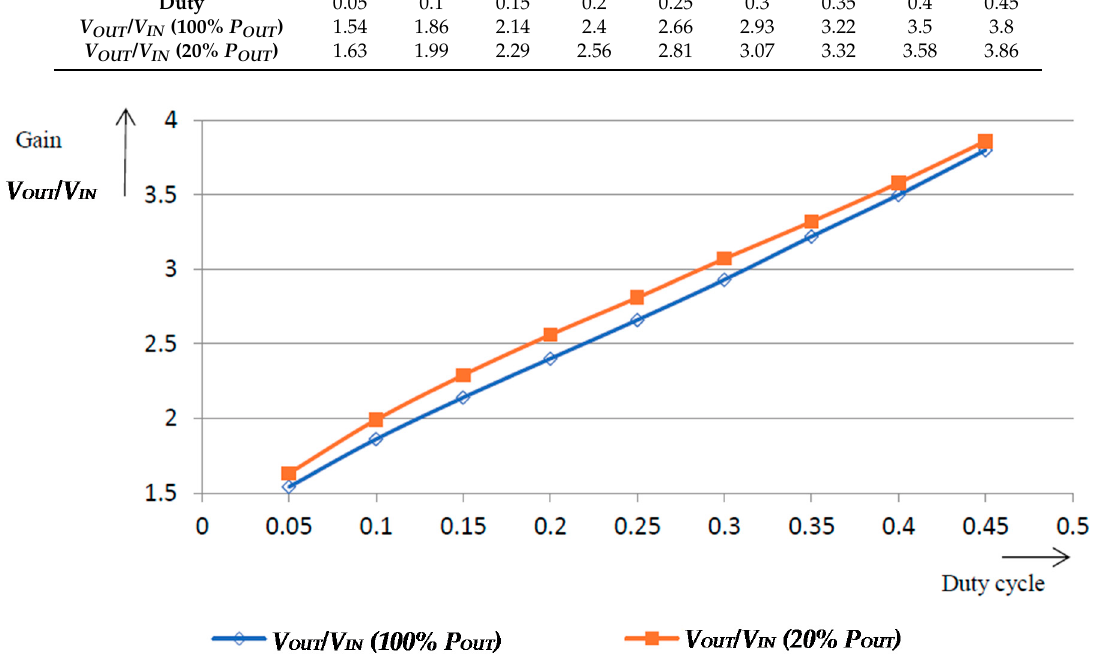
Figure 21. Dependency of converter’s voltage gain on the duty cycle at P OUT = 100% and P OUT = 20%.